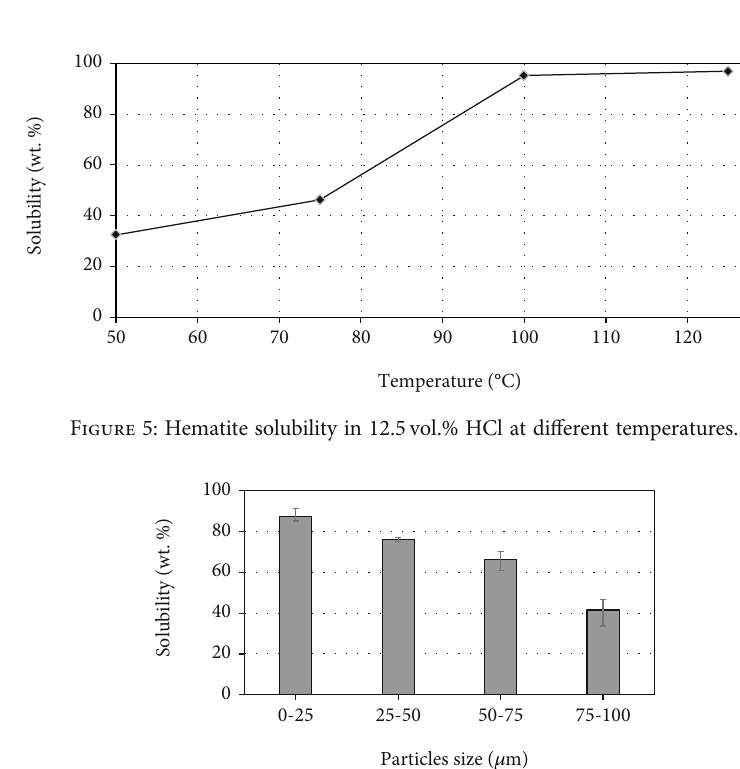
Figure 4: Hematite solubility at di ff erent HCl concentrations.